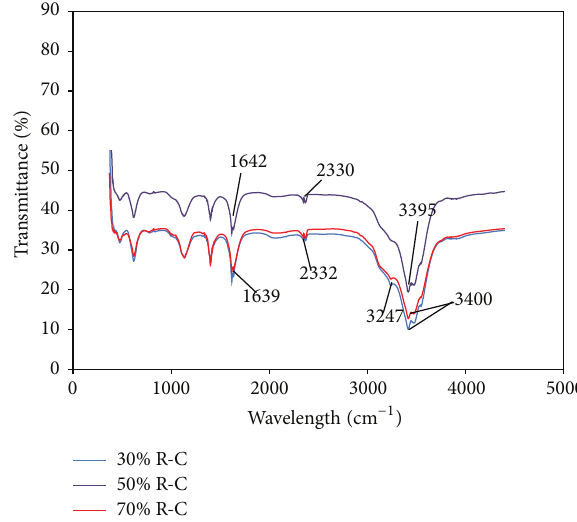
Figure 6: FTIR spectra of blended samples of gasification by- products (resin and char